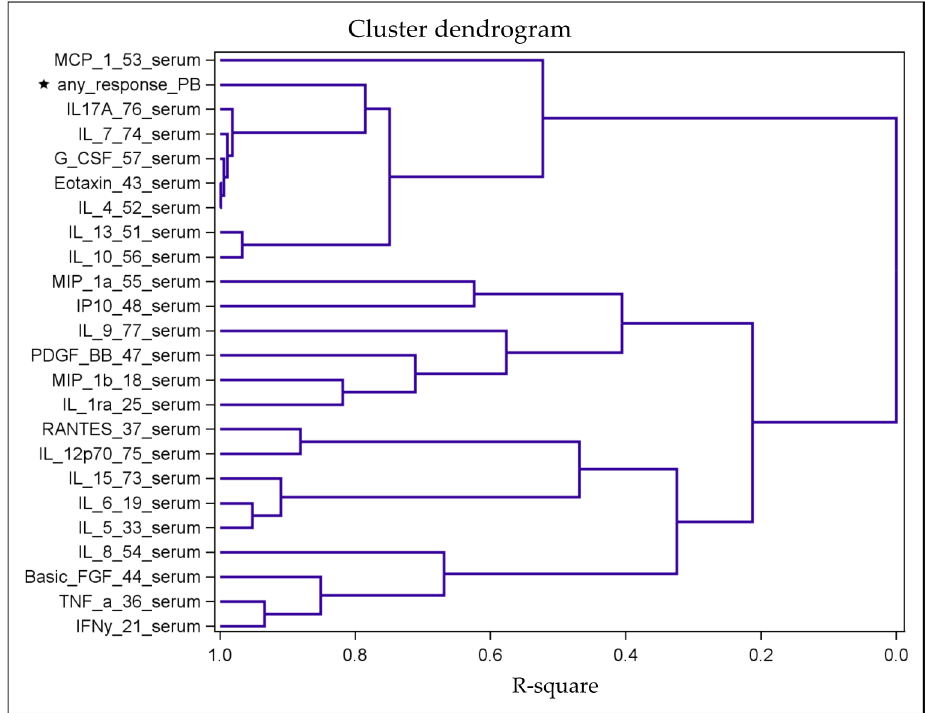
Figure 2. Tree-structured dendrogram resulting from the hierarchical clustering analysis based on the correlation matrix of all cytokine and response data. The R-square value is the proportion of variance accounted for by the cluster. For example, the variables IL-4, eotaxin, G-CSF, IL-7 and IL-17A represent a cluster of variables with similar correlations with the response variable (“any_response_PB”; marked with an asterisk). In contrast, the dendrogram shows a marked distance between the variables IL-6 and IL-8 and the response variable, indicating a weak correlation.